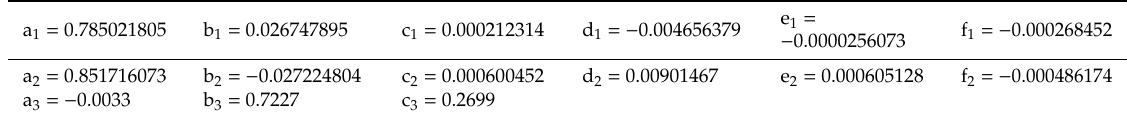
Table 3. Coe ffi cients for the air-condenser